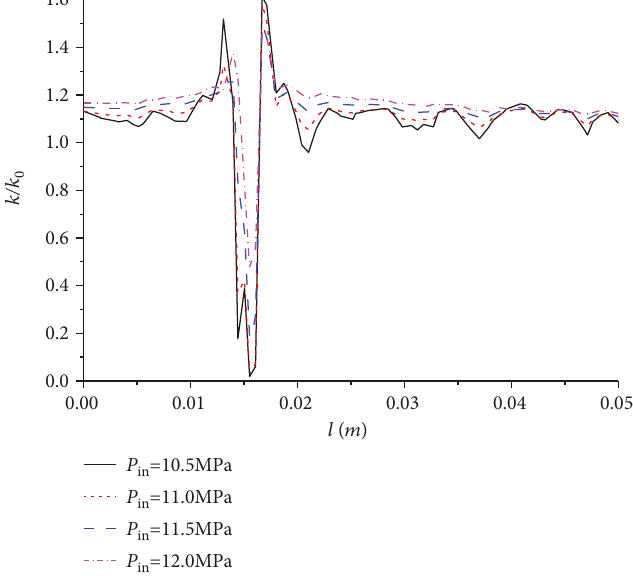
Figure 22: Evolution of the permeability ratio k / k